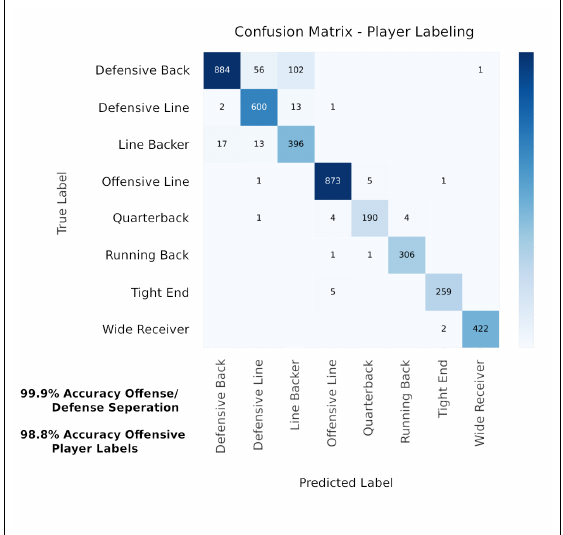
Figure 19. Confusion matrix of player-labeling module—the player-labeling module reliably differ- entiates offensive players from defensive players. Out of 2075 players predicted to be on offensive, only 2 players were originally on defense, giving 99.9% accuracy in separating offensive players from defensive players. Additionally, out of the 2075 players predicted to be on offense, 2050 players were classified with the correct player labels, giving 98.8% accuracy in the offensive player